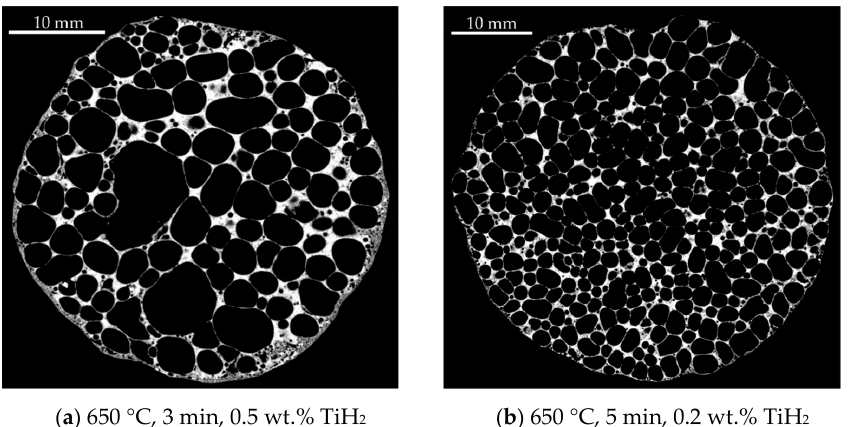
Figure 12. XRM sectional images of sample ( a ) no. 17 with foaming temperature of 650 °C, foaming duration of 3 min, 0.5 wt.% TiH 2 and ( b ) no. 21 with foaming temperature of 650 °C, foaming duration of 5 min, 0.2 wt.% TiH 2 ).